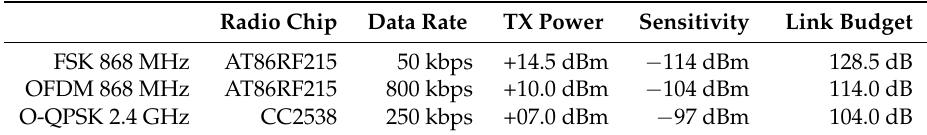
Table 1. The Physical Layer (PHY) layers